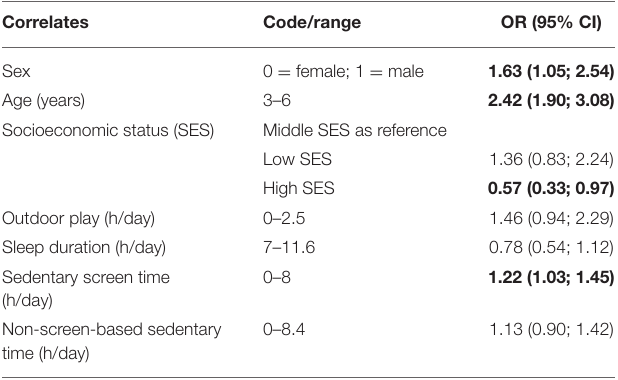
TABLE 2 | The association between screen time and children with overweight and obesity by logistic regression analysis among preschoolers in the PATH-CC study ( n =